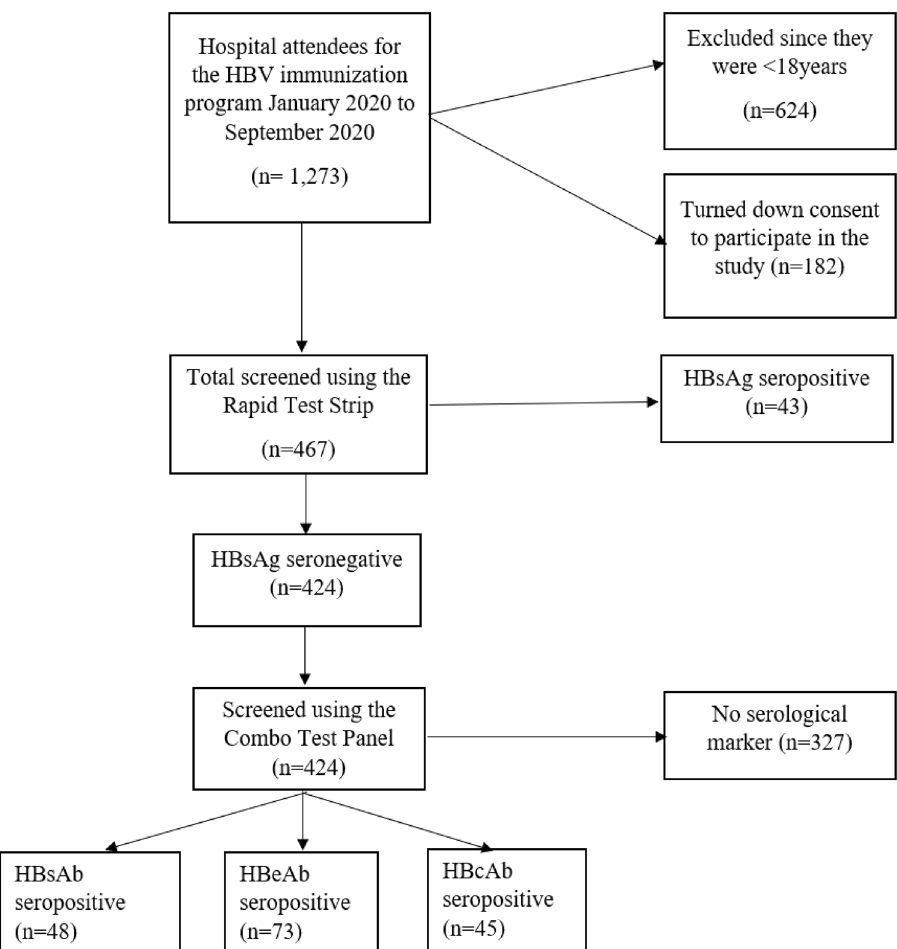
Figure 1. Screening algorithm over a period of 9 months; HBV hepatitis B virus, HBsAg hepatitis B surface antigen, HBsAb hepatitis B surface antibody, HBeAb hepatitis B pre-core antibody, HBcAb hepatitis B core